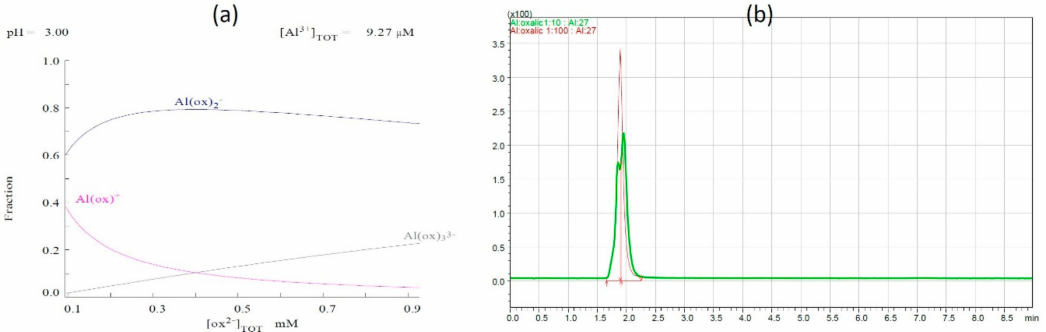
Figure 4. ( a ) Data from chemical modeling program for Al / oxalate 1:10 and 1:100 molar ratio and ( b ) overlapped chromatograms for Al / oxalate 1:10 and 1:100 molar